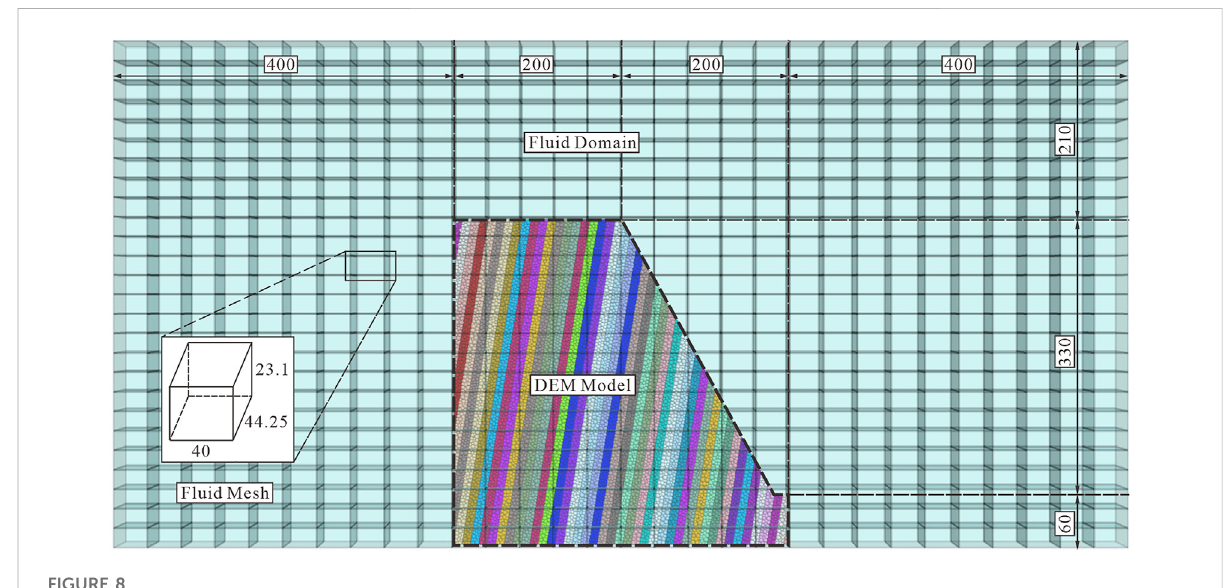
FIGURE 8 Schematic diagram of the submerged anti-dip slope (units: mm).